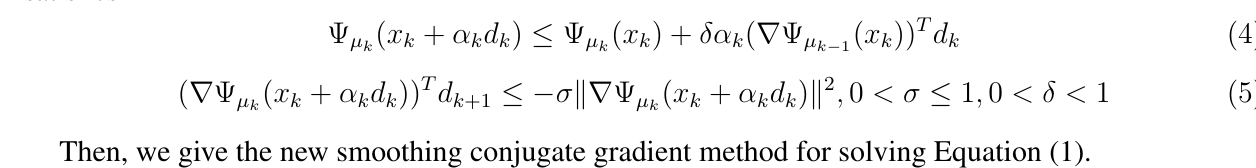
Algorithm 1: Smoothing Conjugate Gradient